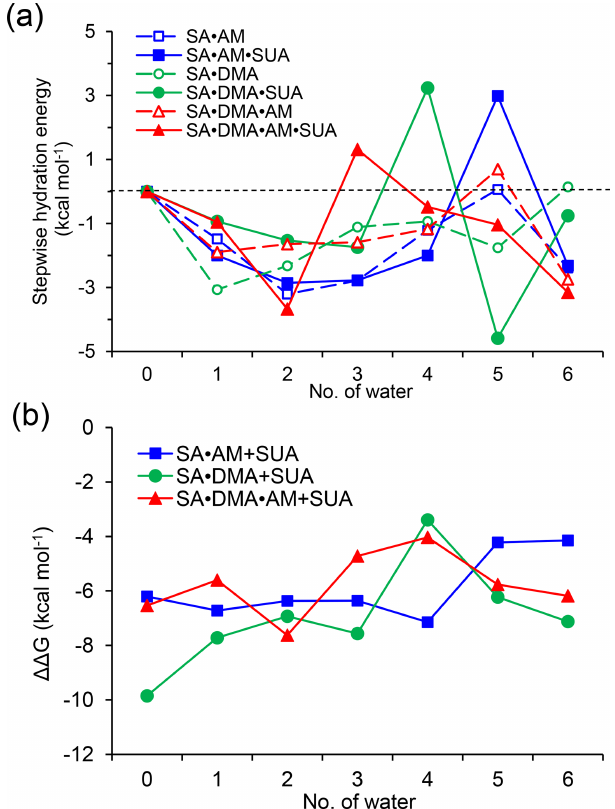
Figure 5. Stepwise hydration free energies (a) and the relative Gibbs free energy changes due to addition of one SUA molecule (cid:113) to SA base clusters (b) at T = 298 . 15K and p = 1atm. The free energy is calculated at the PW91PW91/6-311 ++ G(2d, 2p)